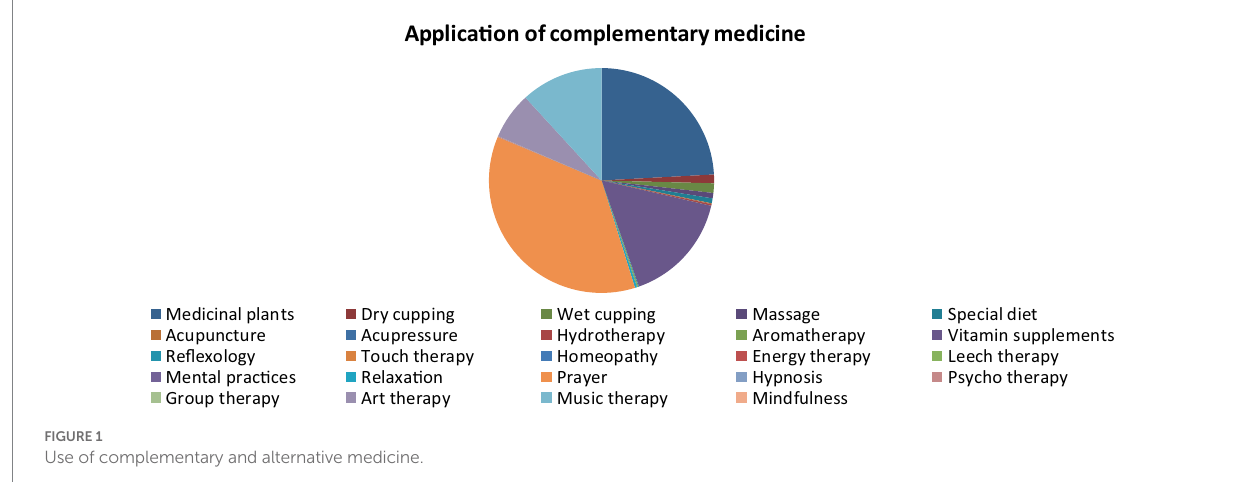
FIGURE 1 Use of complementary and alternative